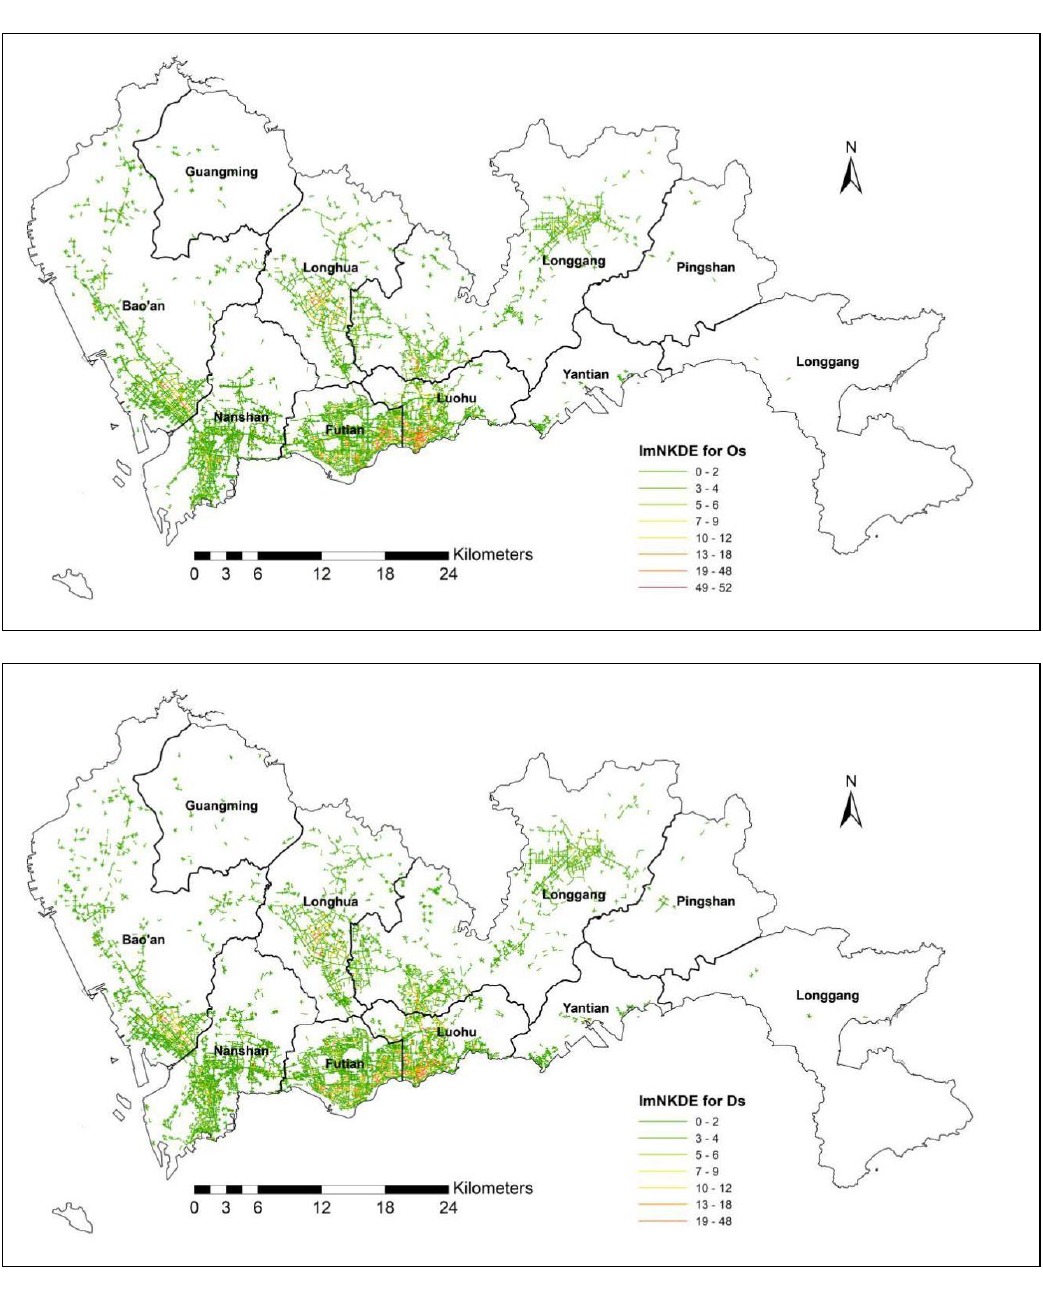
Figure 8. ImNKDE for Os ( Top ) and Ds ( Bottom ).